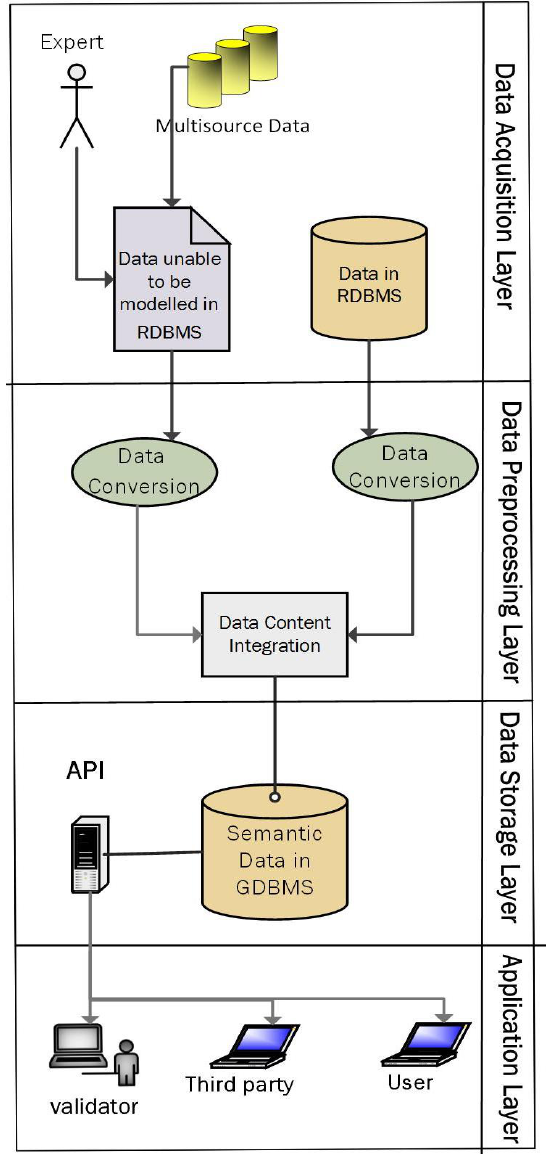
Figure 1. Spatial Semantic Web Multi-Layer